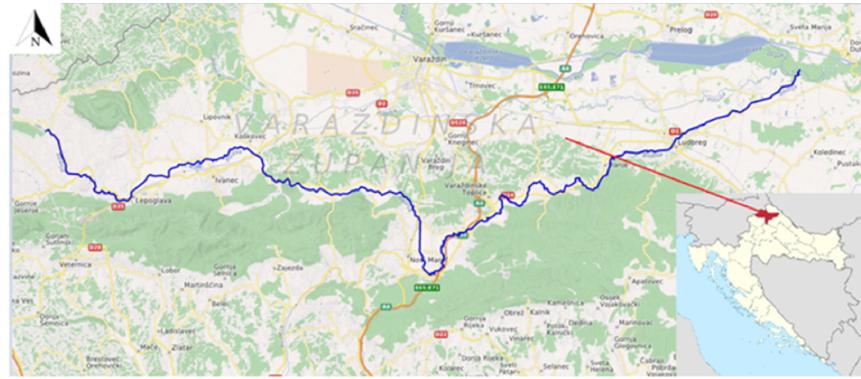
Figure 1. River Bednja in Croatia [17].